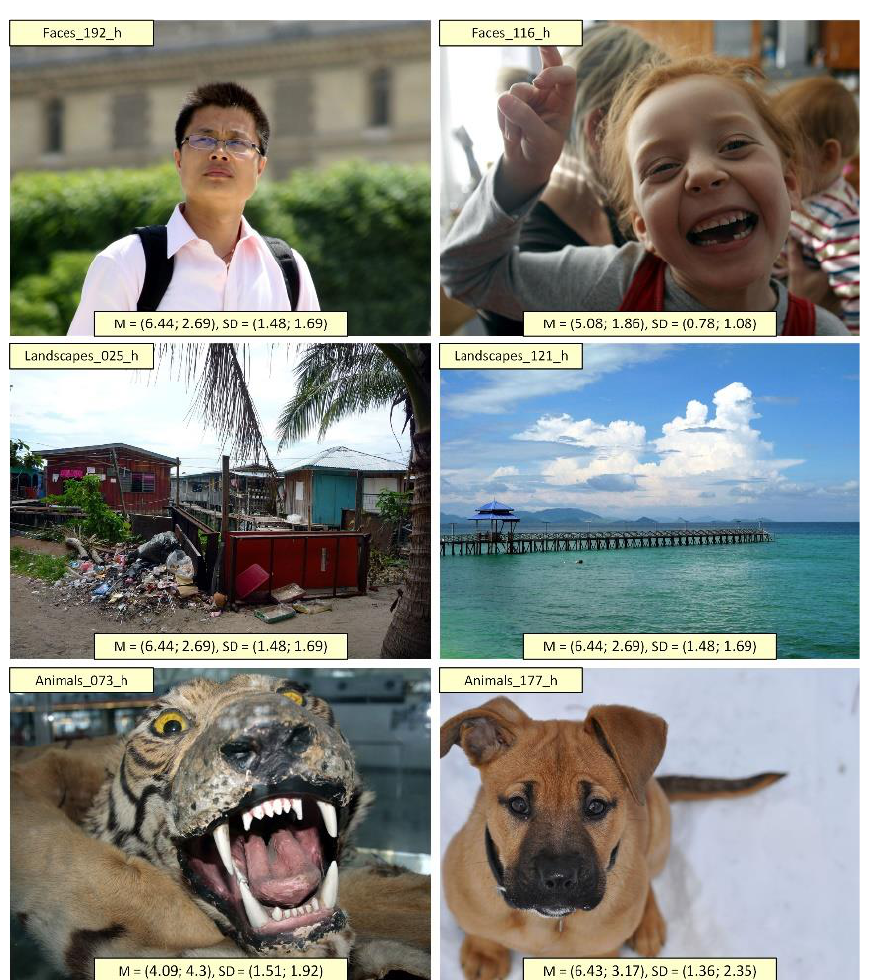
Figure 3. Examples of 6 pictures from the NAPS repository used in the experiment annotated with their dimensional emotion values: mean ( 𝑣𝑎𝑙_𝑆𝐴𝑀_𝑀 , 𝑎𝑟𝑜_𝑆𝐴𝑀_𝑀 ) and standard deviation ( 𝑣𝑎𝑙_𝑆𝐴𝑀_𝑆𝐷 , 𝑎𝑟𝑜_𝑆𝐴𝑀_𝑆𝐷 ). From top to bottom row, the pictures belong to the subgroups faces, landscape, and animals, respectively. Reproduced with permission from [22].